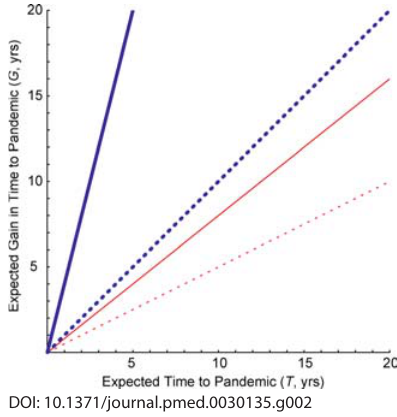
Figure 2. Expected Gain in Time to a Pandemic (G) of a Containment Policy as a Function of the Expected Time to Introduction (T) of a Pandemic-Capable Strain Either infi nite containment attempts (blue) are possible or only a single containment attempt (red) is possible, and we assume an optimistic (80%, solid) or pessimistic (50%, dashed) probability of success for each containment. G is defi ned as the difference in the expected time to a pandemic under the status quo and the containment policy. The Poisson hazard of introduction of pandemic-capable strains (λ) is the reciprocal of the expected time to introduction (T) . The results are identical if the hazard of introduction is fi xed but